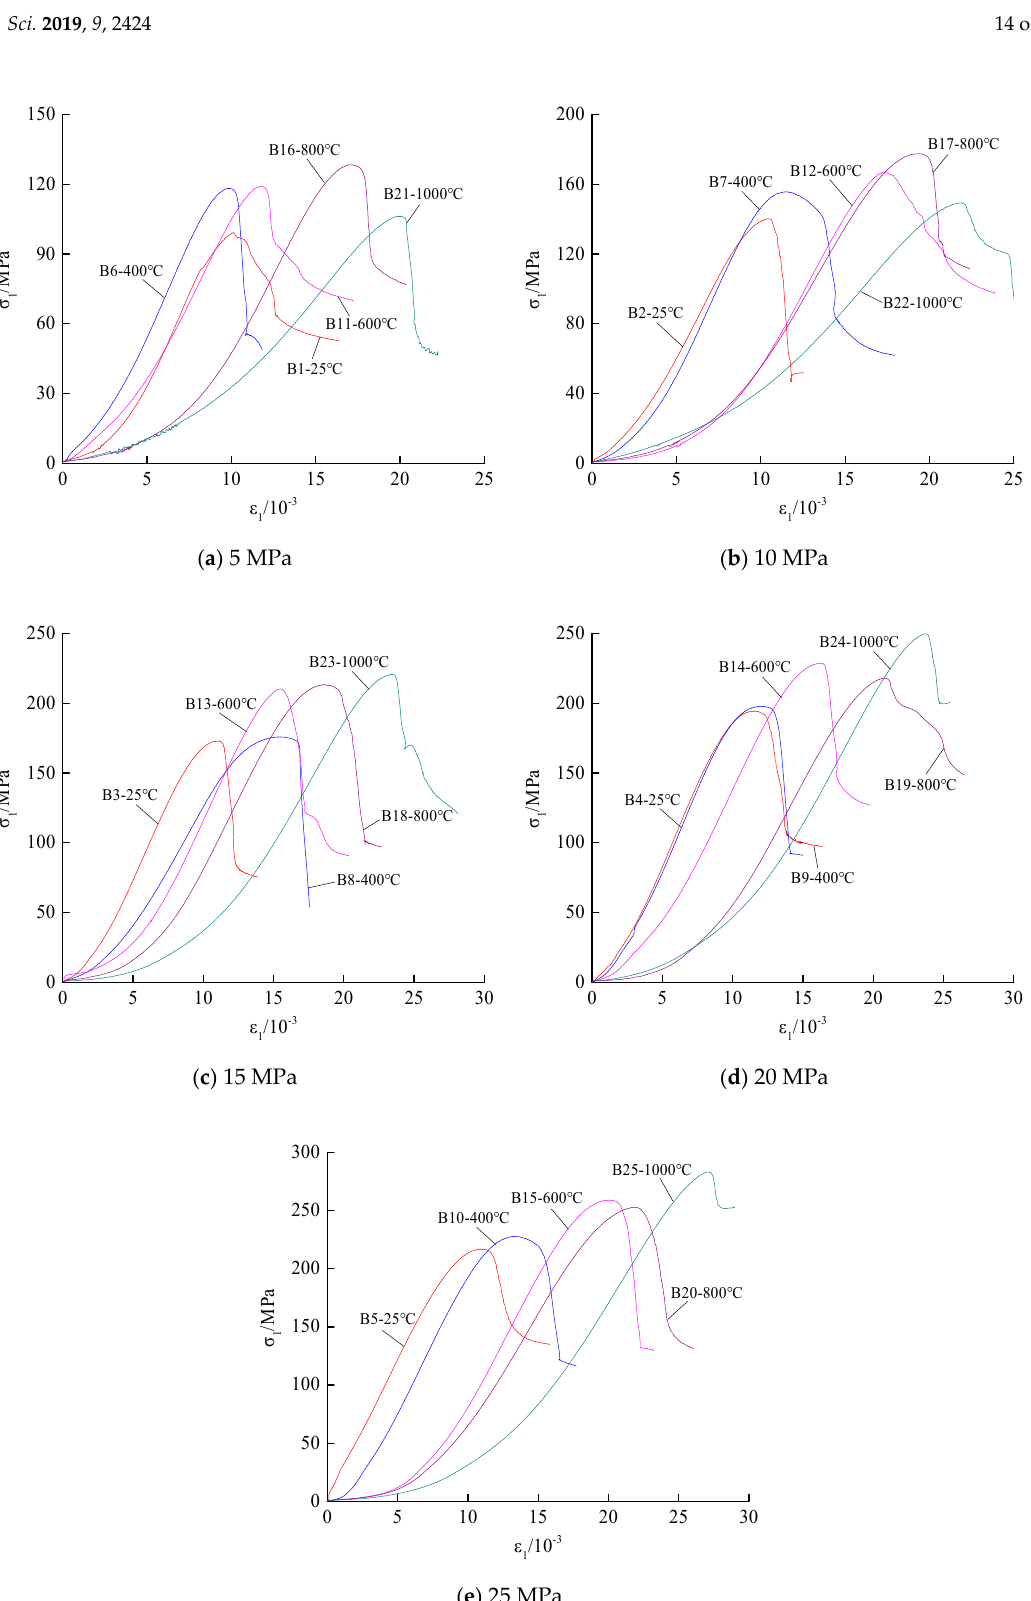
Figure 12. Complete stress–strain curve of samples after high temperature under conventional triaxial compression condition.